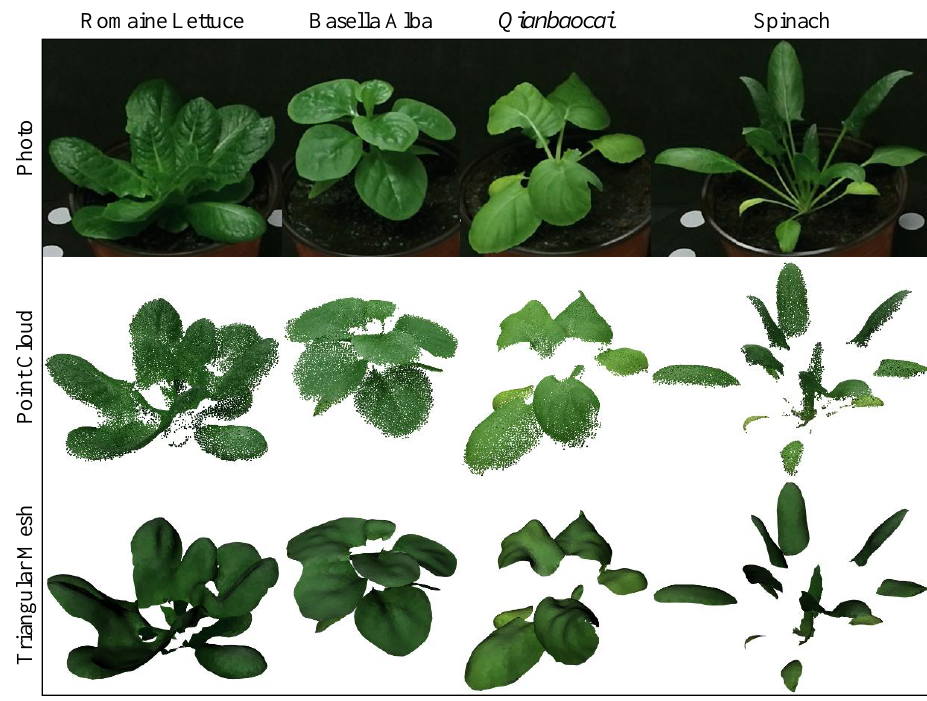
Figure 16. 3D reconstruction results for different species of leafy vegetables. The Qianbaocai is a hybrid of Brassica oleracea L. and Brassica campeseris L.